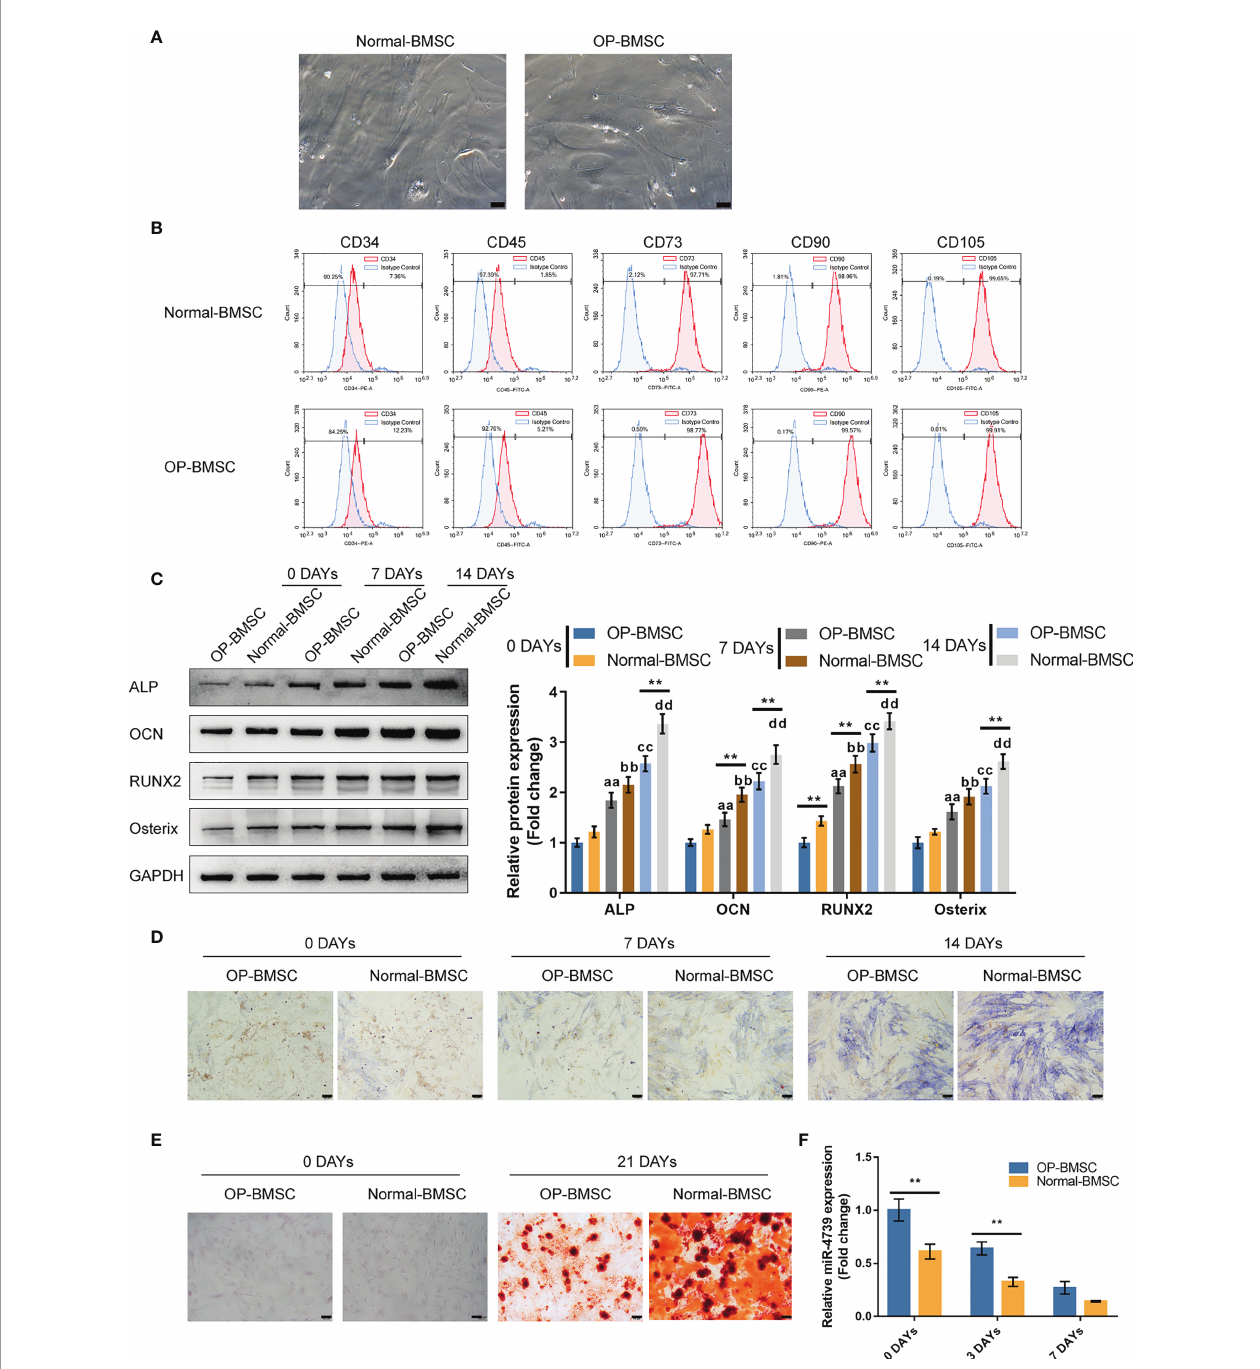
FIGURE 2 | Isolation and osteogenic differentiation of BMSCs (A) Normal and osteoporotic BMSCs were isolated from normal and osteoporotic bone marrow tissues, respectively (the scale bar is 50 m m). (B) Flow cytometry was performed to identify isolated BMSCs detecting CD34, CD45, CD73, CD90, and CD105. (C) Normal and osteoporotic BMSCs were induced towards osteogenic differentiation for 21 days, and the protein levels of ALP, OCN, Runx2, and Osterix were examined using Immunoblotting on days 0, 7, and 14 of osteogenic induction (C) ; ALP staining was performed on day 0, 7, and 14 of osteogenic induction (D) ; the formation of mineralized nodules were examined using Alizarin red staining on days 0 and 21 of osteogenic induction (E) ; the expression of miR-4739 was examined using qRT-PCR on day 0, 3, and 7 of osteogenic induction in normal BMSCs and osteoporotic BMSCs (F) . n=3, **p < 0.01 compared to OP-BMSC. aa p<0.01 compared between 0 days OP-BMSC and 3 days OP-BMSC; bb p < 0.01 compared between 0 days normal-BMSC and 3 days normal-BMSC; cc p<0.01 compared between 0 days OP-BMSC and 14 days OP-BMSC; dd p < 0.01 compared between 0 days normal-BMSC and 14 days